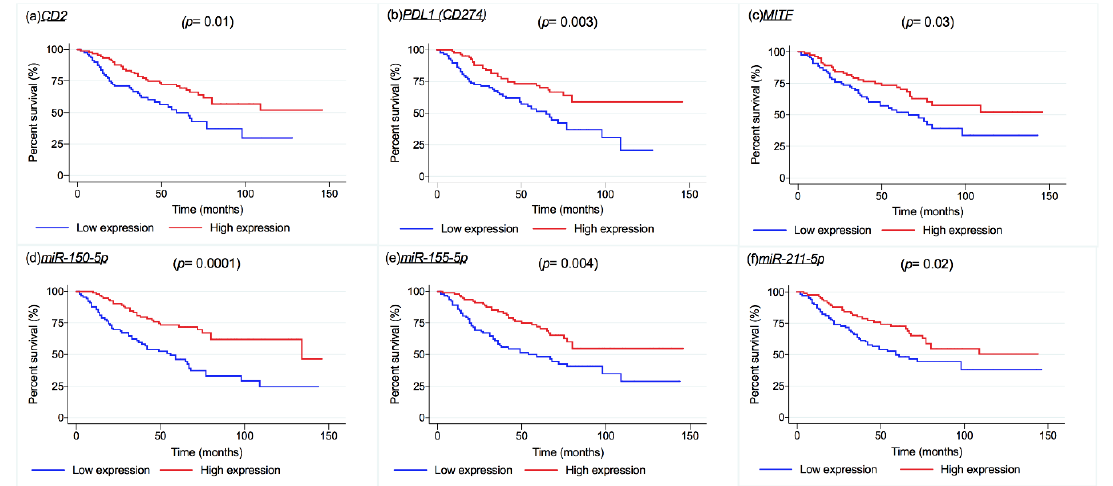
Figure 6. Kaplan Meier survival curves for melanoma-specific survival (MSS) for CD2, p = 0.01 ( a ); CD274, p = 0.003 ( b ); MITF, p = 0.03 ( c ); miR-150-5p, p = 0.0001 ( d ); miR-155-5p, p = 0.004 ( e ); and miR-211-5p, p = 0.02 ( f ). The gene and miRNA expression were dichotomized in low expression and high expression for the median value of each transcript ( p values on the graph refer to the Log-rank test). Table 4. Results of the Cox multivariate analysis ( p <